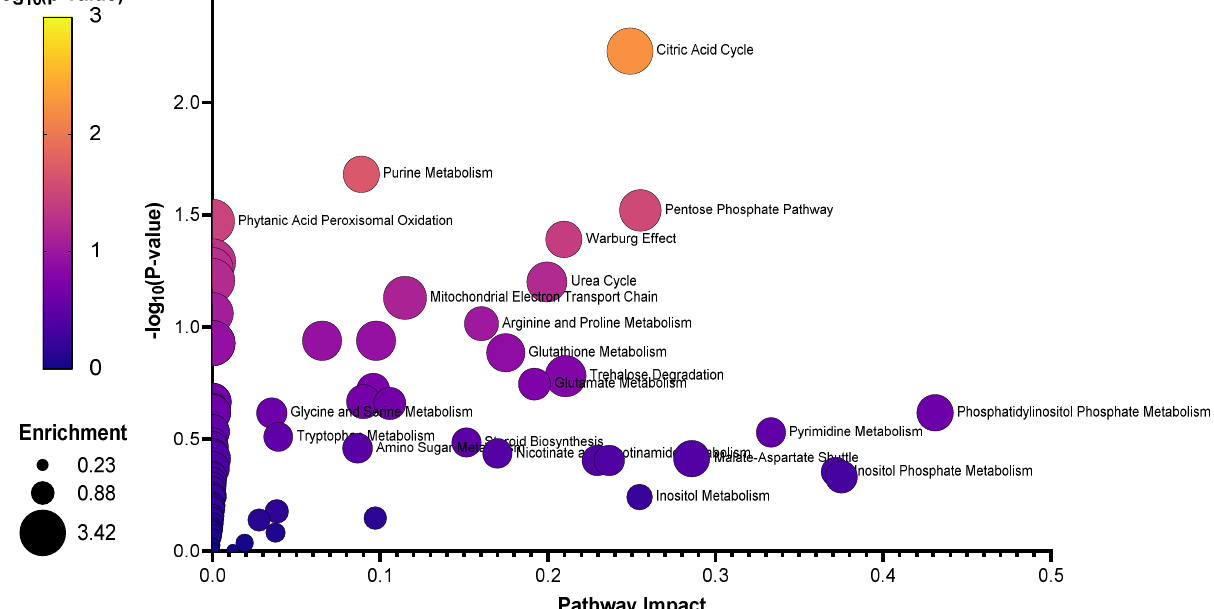
Figure 6. Enrichment analysis of the identified metabolites and lipids of importance from nasal wash samples.